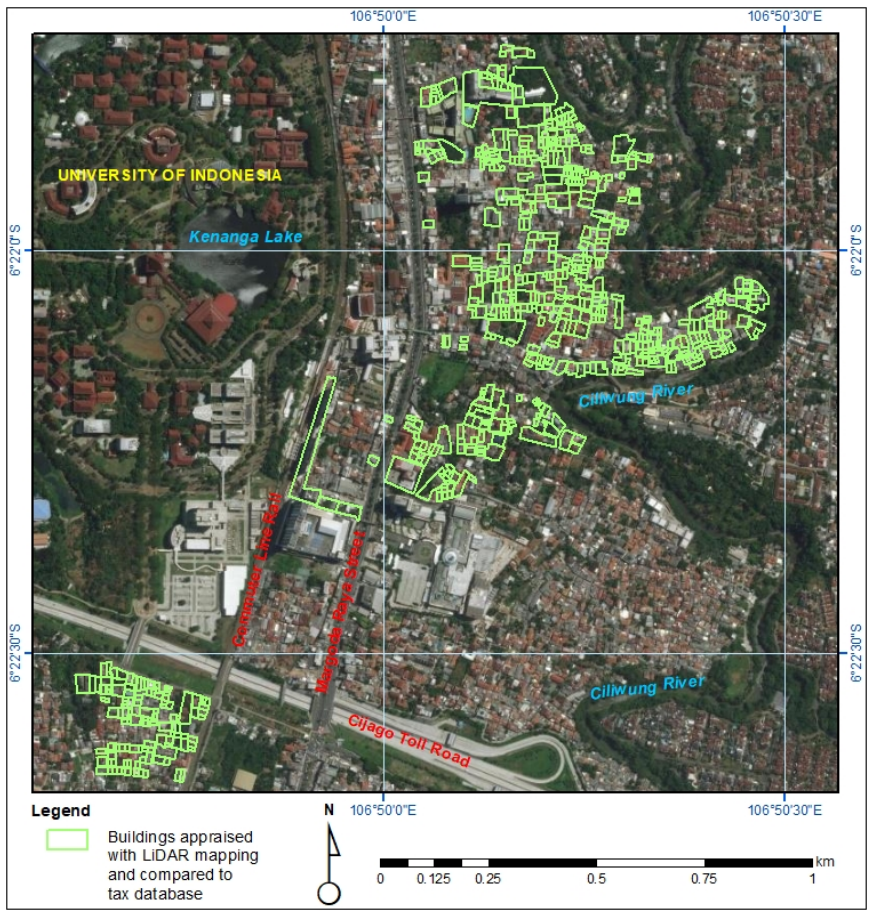
Figure 6. Map of building parcels under study.